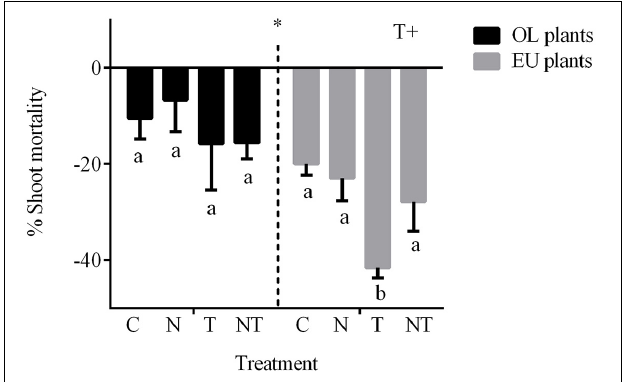
FIGURE 4 | Shoot mortality measured as percentage comparing the mortality between the beginning (T1) and the end of the experiment (T4) in OL and EU plants exposed to nutrient (N), temperature (T) and their combination (NT). Asterisks indicate differences between OL and EU plants (ANOVA 3-way); (+) indicates factors where significant differences were found between levels of factor after ANOVA 2-way and post hoc test. Different lowercase letters indicate the groups of homogeneous means obtained in the post hoc ( P <